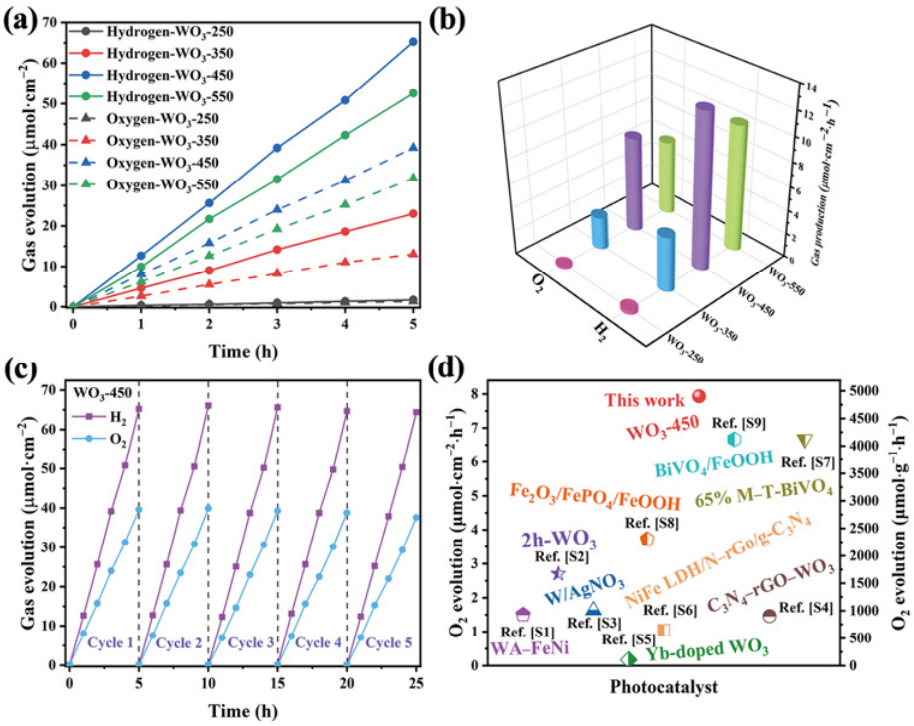
Fig. 5 (a) Photoelectrocatalytic overall water splitting and (b) rates of H 2 and O 2 production over various samples, (c) photoelectrocatalytic durability test, and (d) oxygen evolution rates for WO 3 -450 in comparison with other